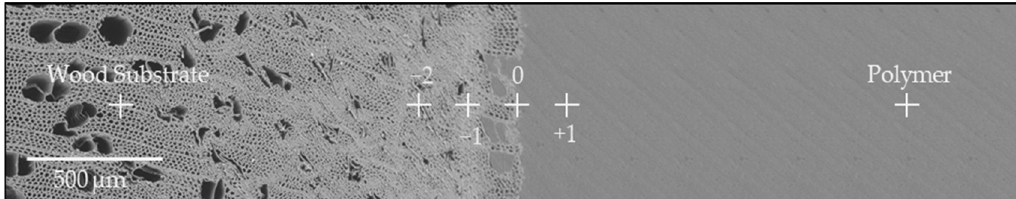
Figure 4. Micrograph of the overmolded solid wood specimens for X-ray photoelectron spectroscopy analyses (XPS) used to determine the elementary distribution of C, O and N and for high-resolution deconvoluted XPS spectra within the samples cross section, indicating the position of the X-ray beam.